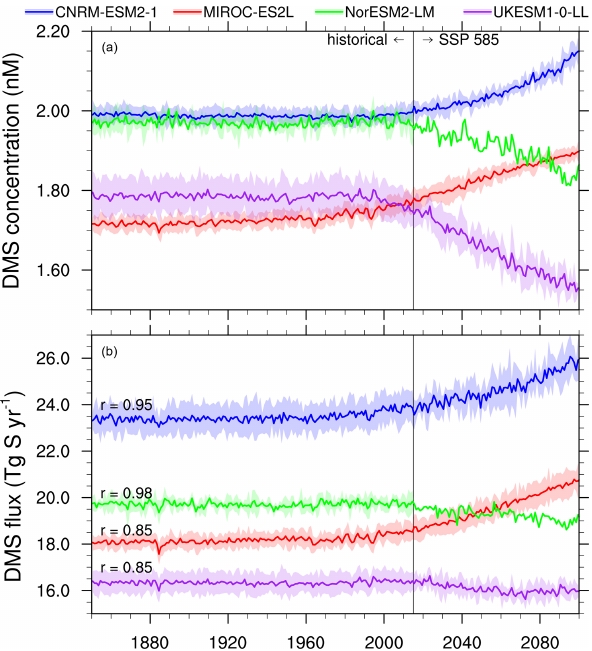
Figure 9. Time series of mean annual global area-weighted sur- face ocean DMS concentration (nM, a ) and annual global DMS flux (TgSyr − 1 , b ) over 1850–2100 (CMIP6 historical and ssp585 simulations). The ensemble mean of each model (thick lines), ± 2 standard deviations (shaded envelopes), is plotted. Note that the di- mension of each ensemble may be different in the historical and in the ssp585 experiments (see Table 2). The Pearson correlation coef- ficient between both time series is indicated for each model on the bottom plot. Table 7. Comparison of the mean and relative difference of DMS concentration (conc. in nM) and flux (TgSyr − 1 ) between the be- ginning of historical period (1850–1865) and the end of the ssp585 period (2085–2100) as shown in Fig.